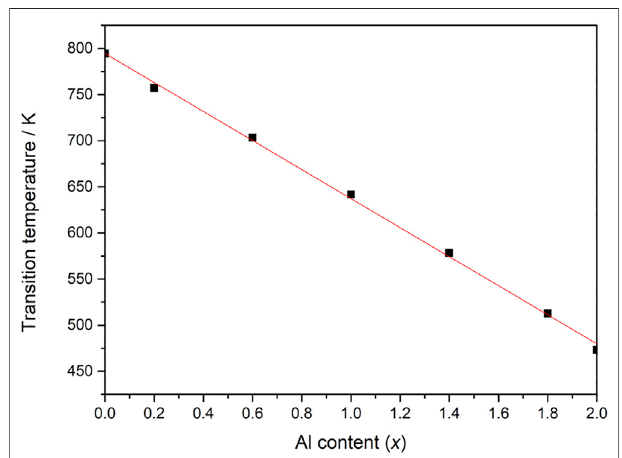
FIGURE 10 | Temperature of monoclinic-to-orthorhombic phase transition in Fe 2- x Al x Mo 3 O 12 as a function of Al content ( x ) (styled from data in Ari et al.,